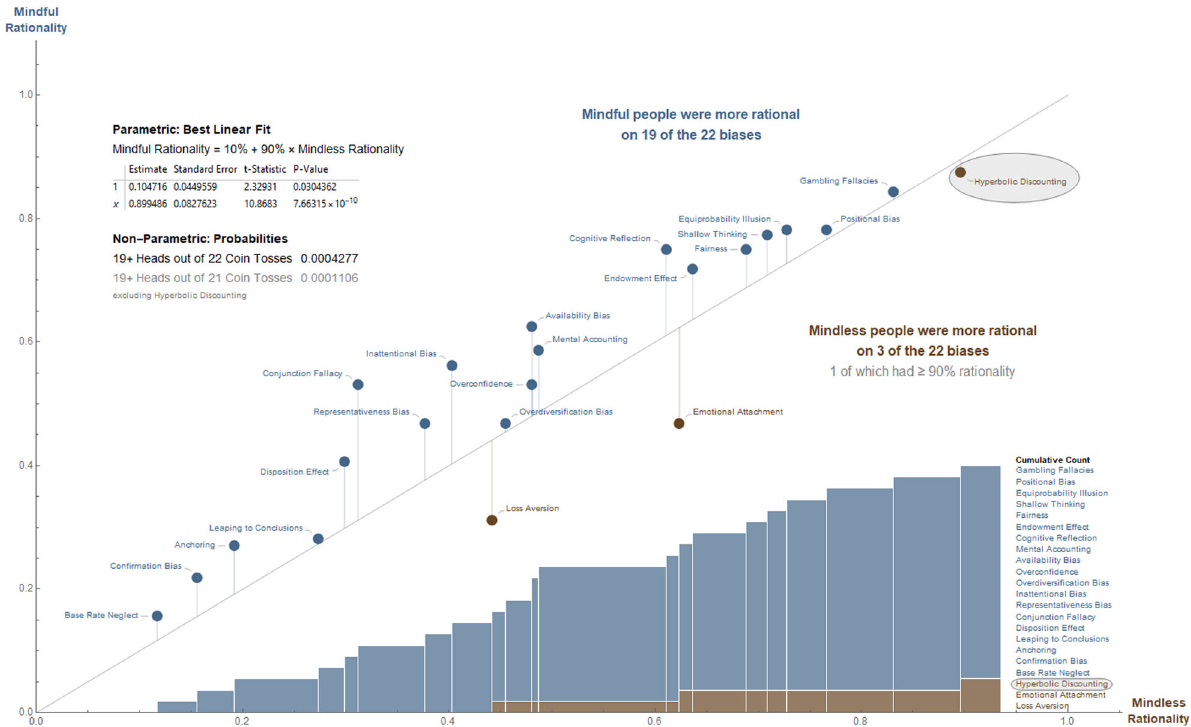
Fig. 1 Mindful vs. mindless rationality. Average mindful rationality vs. average mindless rationality for each of the 22 questions, as well as the identity line to visualize the differences. Below is a cumulative count of the number of biases for which either the mindful or mindless respondents scored better. Estimates from a linear regression and non-parametric probabilities are also